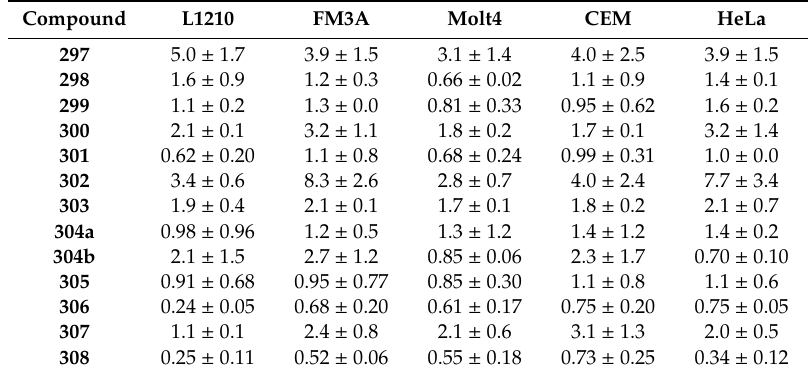
Table 36. In vitro inhibitory e ff ects of compounds 297 – 308 on the proliferation of murine leukemia (L1210), murine mammary carcinoma (FM3A), human T-leukemia (Molt / 4 and CEM), and human cervix carcinoma (HeLa) cells (IC 50 values expressed in µ